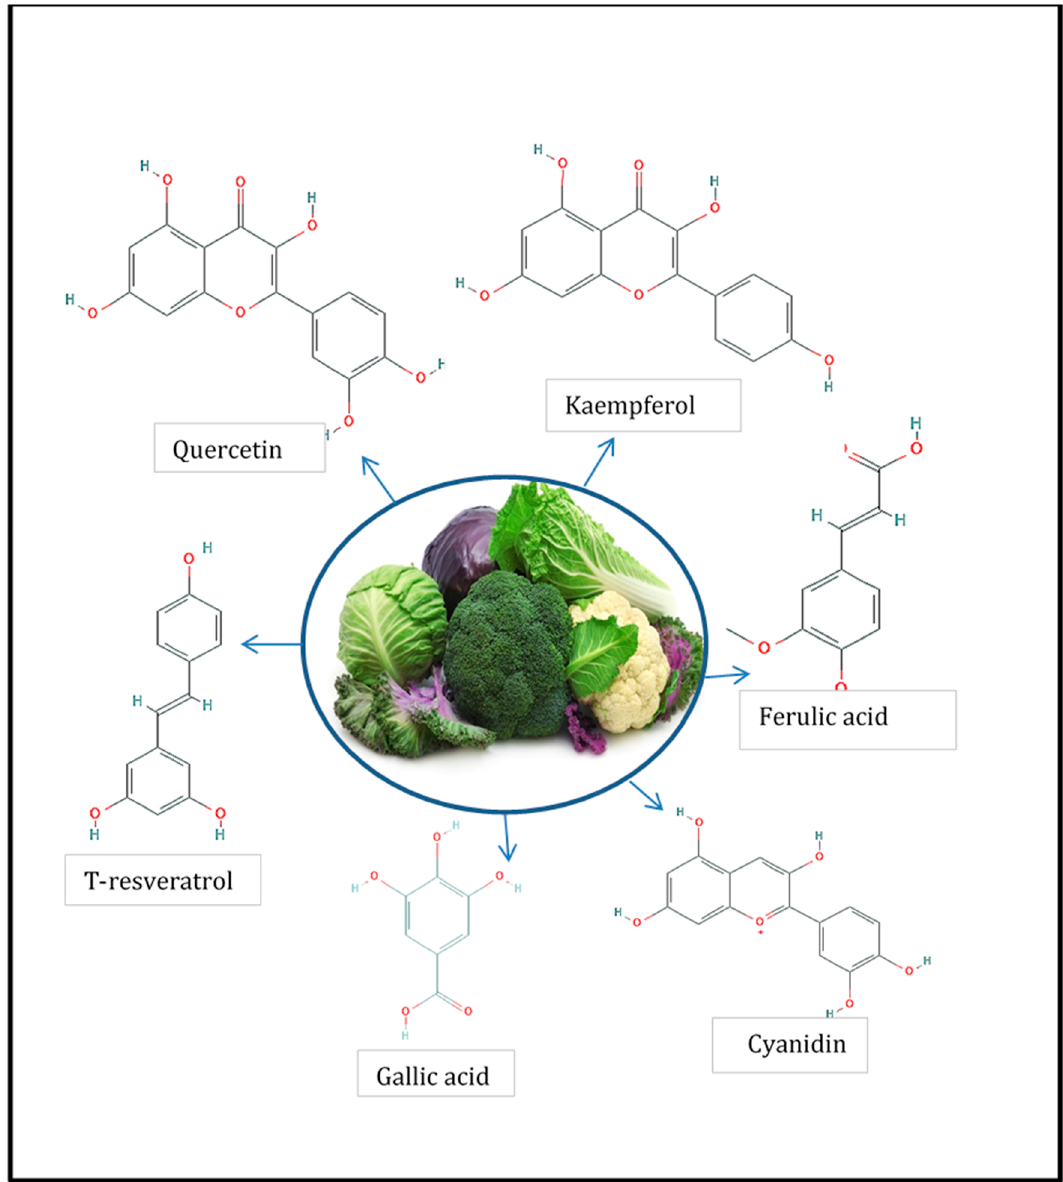
Figure 1. Phenolic compounds present in members of Brassicaceae [12].